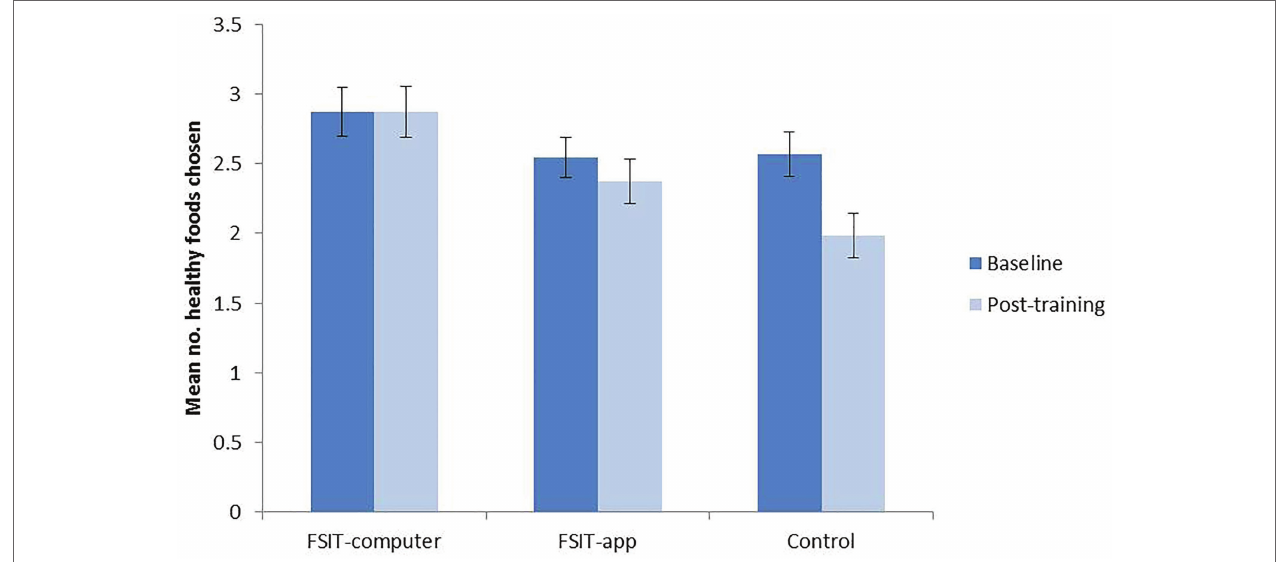
FIGURE 4 | Mean number of healthy foods chosen at baseline and post-training within each condition; error bars show SE.